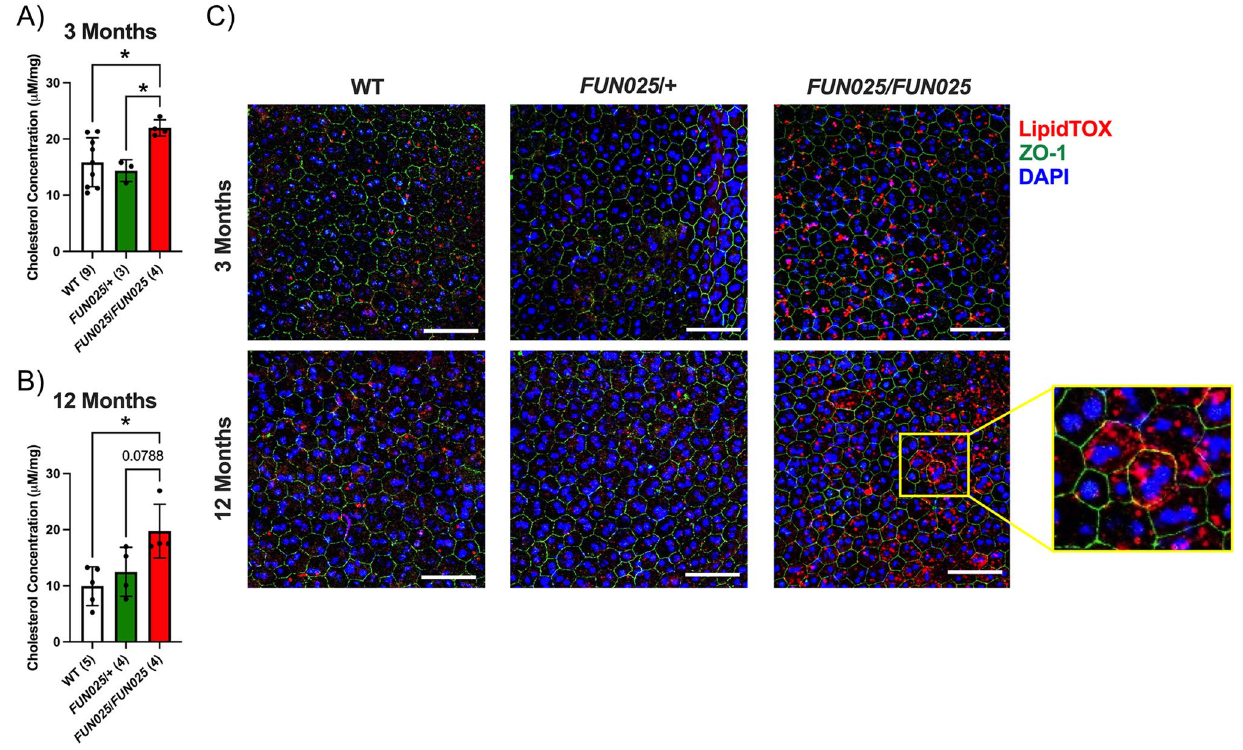
Figure 5. Lipid Levels in WT, Heterozygous and Homozygous Tmem135 Mutant Eyecups. Cholesterol levels in eyecups of ( A ) 3-month-old and ( B ) 12-month-old WT, Tmem135 FUN025 / + ( FUN025/ +) , and Tmem135 FUN025/FUN025 ( FUN025/FUN025 ) mice. * indicates a P < 0.05 significance by post hoc Tukey test following a significant difference detected by one-way ANOVA. Numbers with brackets denote number of mice used for experiment. Each dot represents each individual sample. Data is presented as mean ± s.d.. ( C ) Representative RPE flat mount images after labelling for tight junctions (green) and staining for neutral lipids (red) and nuclei (blue). Mag = 20×, Scale Bar = 25